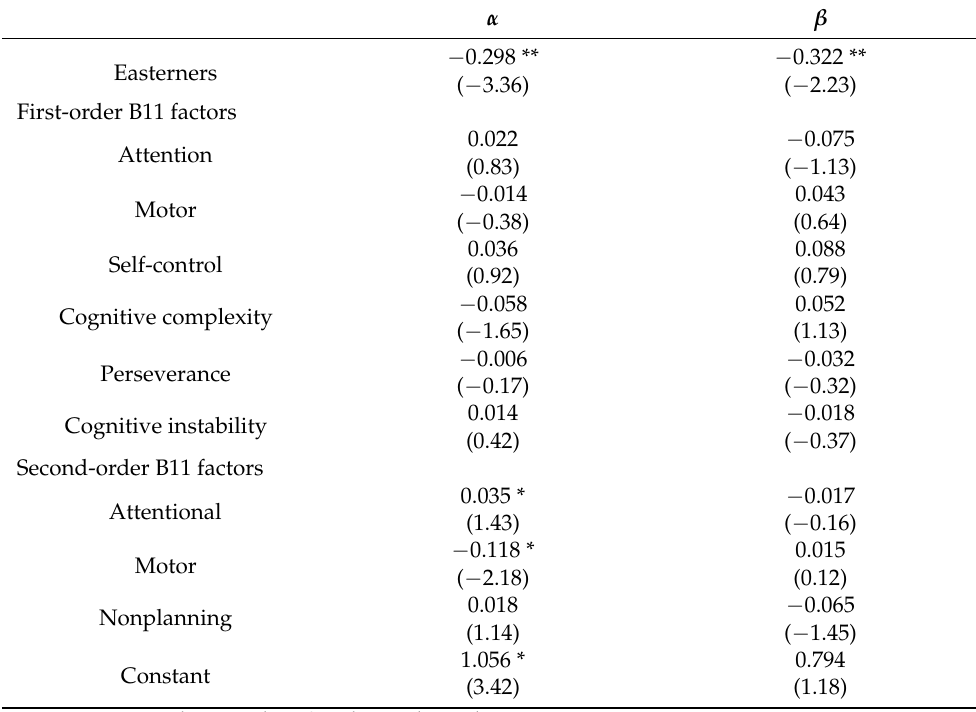
Table 2. Analysis of risk and ambiguity attitudes, including B11 as